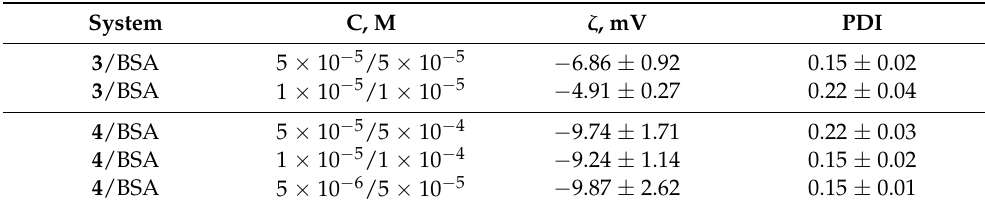
Table 2. Electrokinetic potentials ( ζ ) of the aggregates, obtained for BSA in the presence of the compounds 3 and 4 in PBS (pH = 7.4) at 20 ◦ C, and polydispersity index